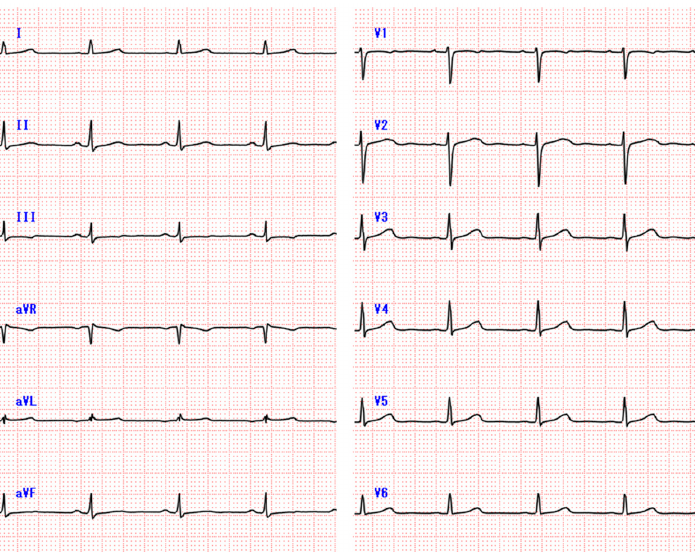
Figure 1. Resting electrocardiogram on second admission. No abnormal electrocardiogram changes were detected on admission.